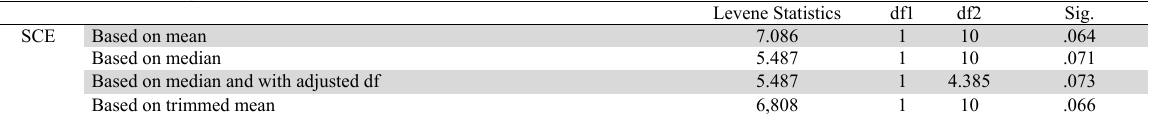
The results of Homogeneity